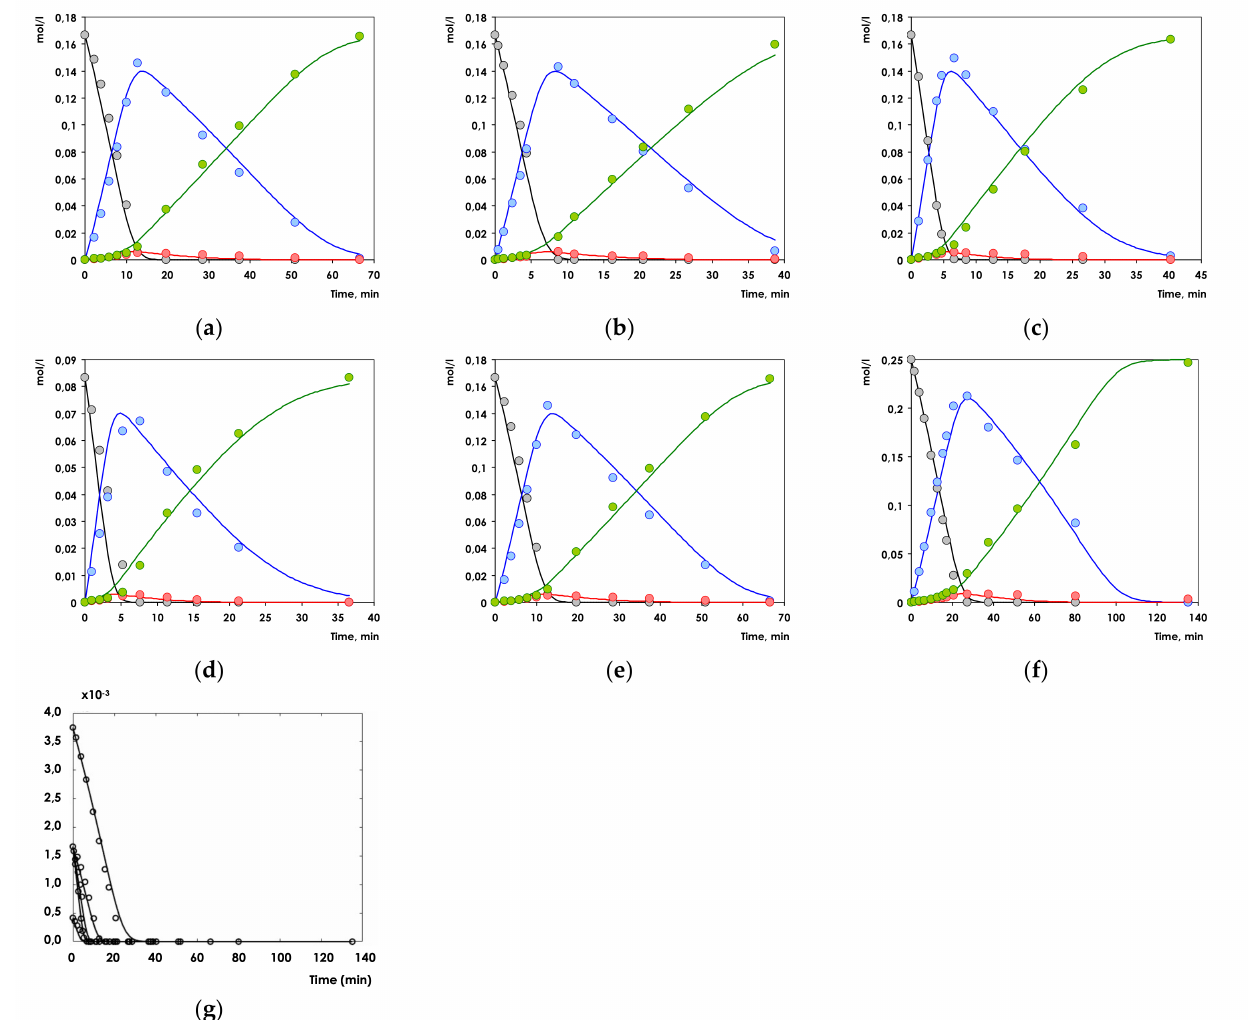
Figure 10. Comparison between calculated (lines) and experimental (symbols) data in 1-Ph-1-Pr hydrogenation over Pd 1 Ag 3 SAA catalyst under different pressures (( a )—5 bar, ( b )—10 bar, ( c )—15 bar; C PhPr = 0.166 mol/L) and initial alkyne concentrations (( d )—0.0830 mol/L, ( e )—0.166 mol/L, ( f )—0.249 mol/L; P = 5 bar). Inlet ( g ) illustrates that the model is capable of adequately capturing the dependence of hydrogenation rate on the initial substrate concentration. Black circles—1-phenyl-1-propyne, blue circles— cis -propenylbenzene, red circles— trans - propenylbenzene, green